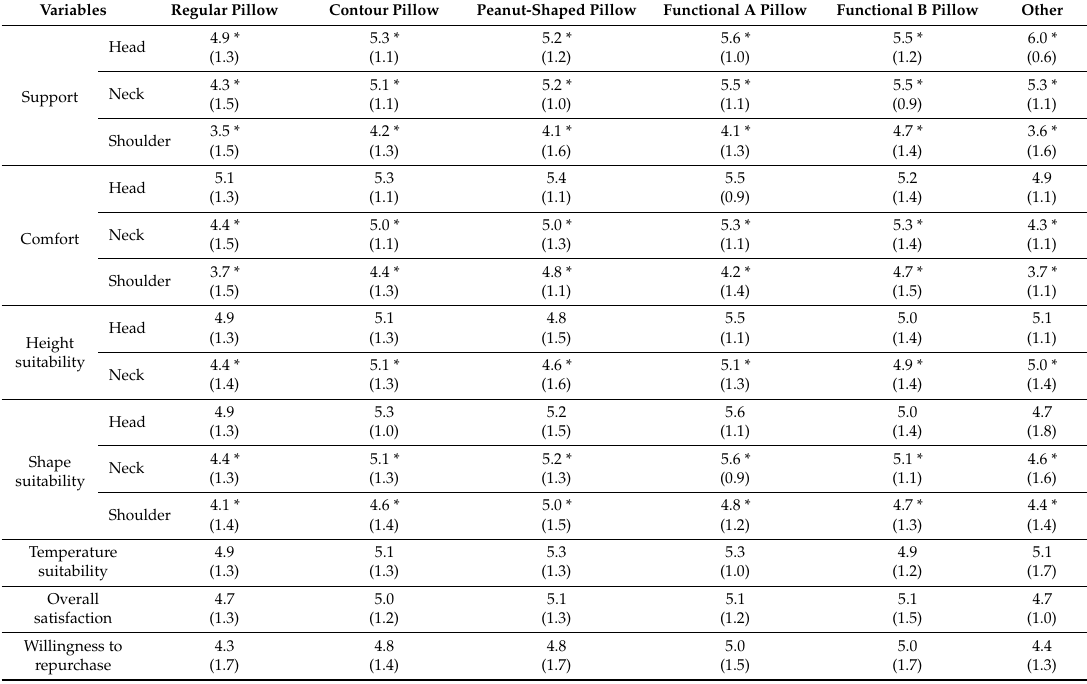
Table 6. ANOVA results of comfort and support by pillow types (Mean (SD)).